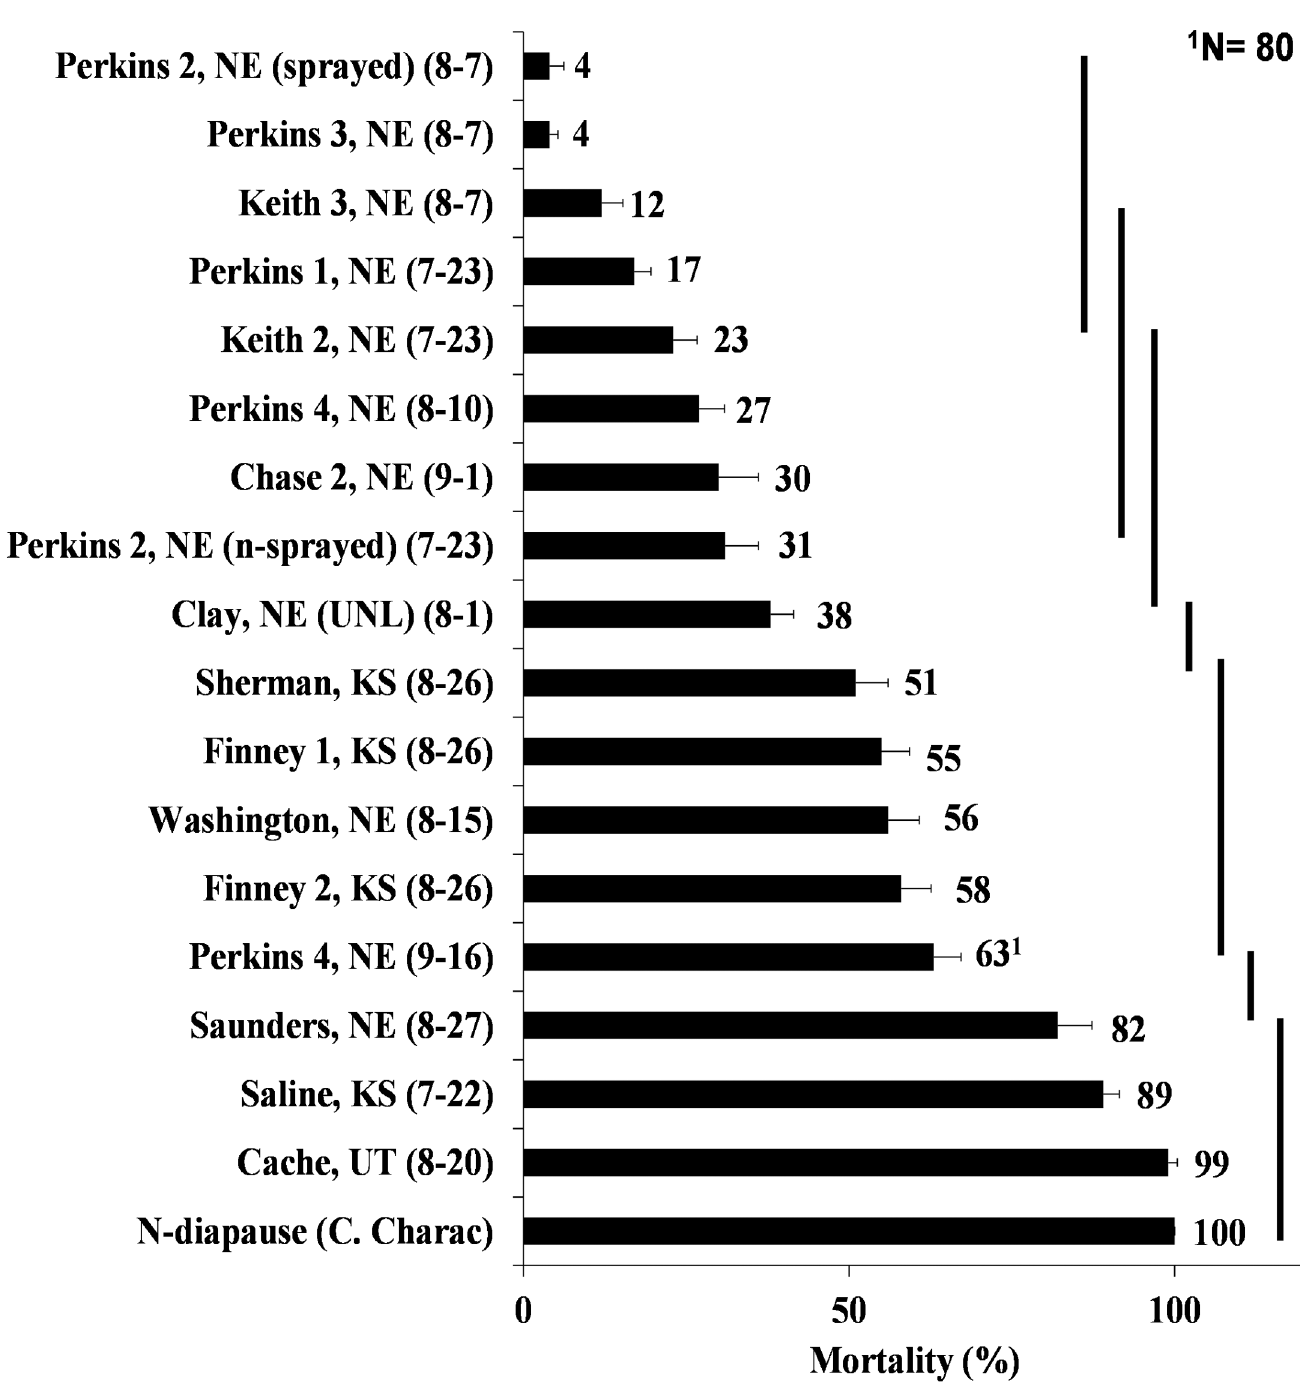
Fig 3. WCR adult mortalities of field populations mostly from several counties in Nebraska and Kansas collected in 2014 (collection date), after exposure to diagnostic concentration of bifenthrin (0.77 μ g of bifenthrin/vial). Means and standard errors are the result of 10 replicates (vials), with 10 beetles per vial (unless otherwise stated). Population means encompassed by the same solid vertical bars are not significantly different and were compared by least squared means with Tukey adjustment at p (cid:1) 0.05 using PROC GLIMMIX in SAS 9.3.